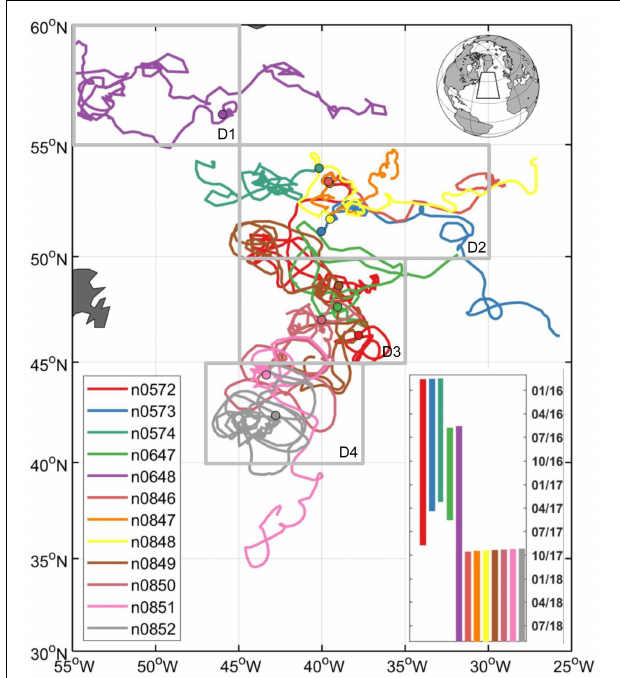
FIGURE 1 | Trajectories of 12 profiling floats deployed during NAAMES expeditions with the initial float deployment locations denoted by filled circles. The bar chart (right bottom) indicates float deployment durations. The float data is available at: